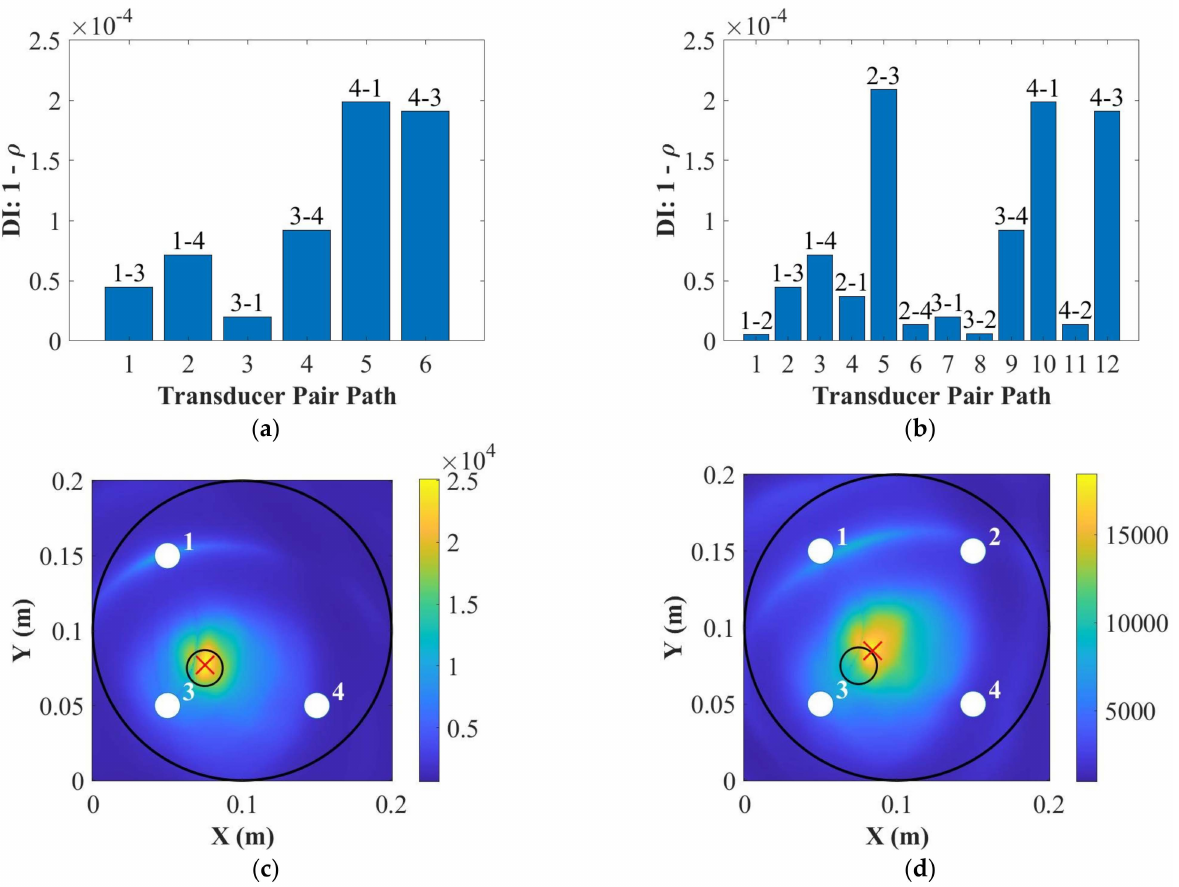
Figure 9. Detection of surface-mounted artificial damage on the bottom of the host structure using ( a ) three PZT transducers and ( b ) four PZT transducers, and localization using ( c ) three PZT trans- ducers and ( d ) four PZT transducers at 250 kHz for the position 1 (where the “ real damage and the “ × ” is the position for predicted